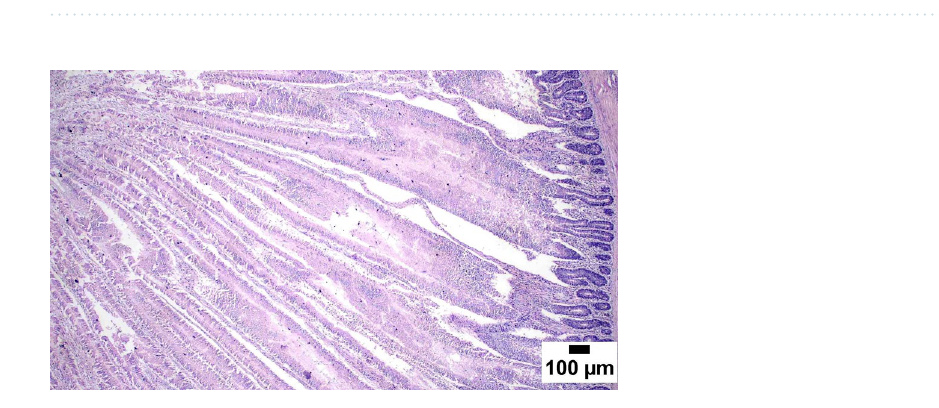
Figure 5. Photomicrograph of the duodenum, C group at 35 days showing long well-oriented intestinal villi with mild inflammation (H&E).